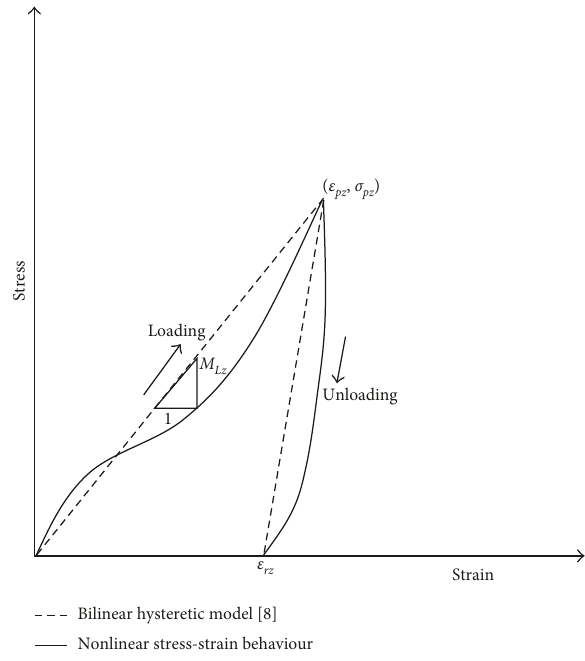
Figure 2: Schematic diagram for stress-strain relation at a depth “ z.